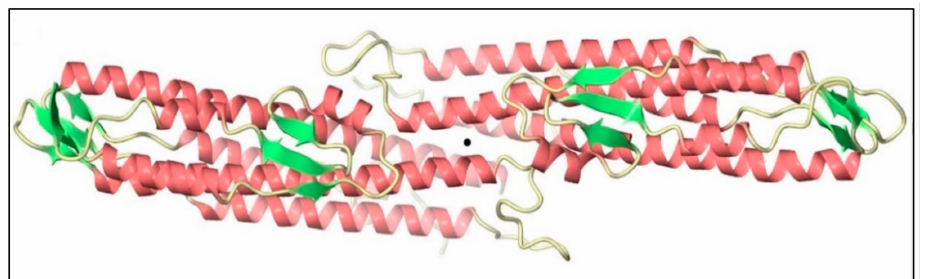
Figure 3. Two monomers of Burkholderia invasion protein D (BipD) within the crystallographic asymmetric unit generated using CueMol. The central black sphere shows that both monomers are connected by helices 4 and 8 with an approximately two-fold symmetry. Adapted with permission from [44]. Copyright © 2006 Elsevier